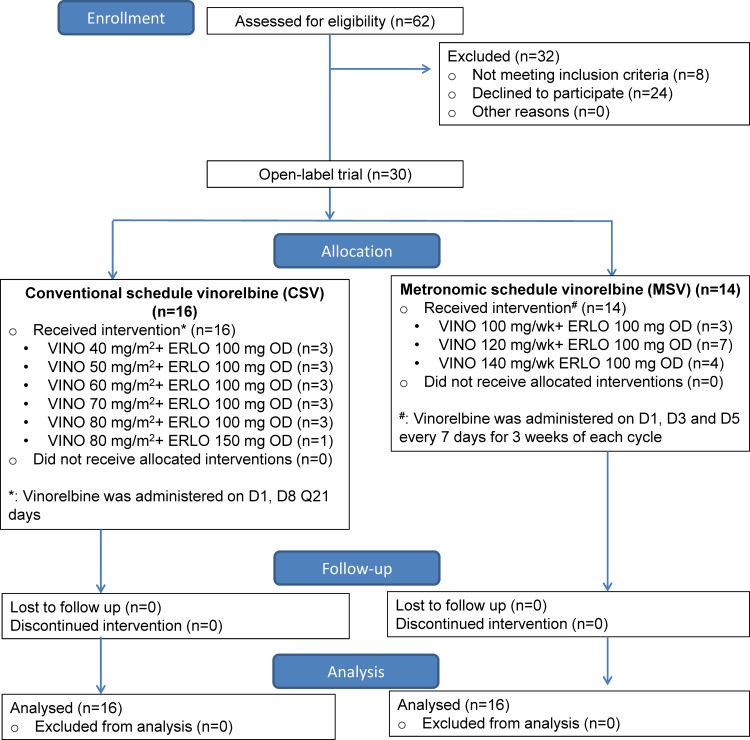
CONSORT Flow diagram.